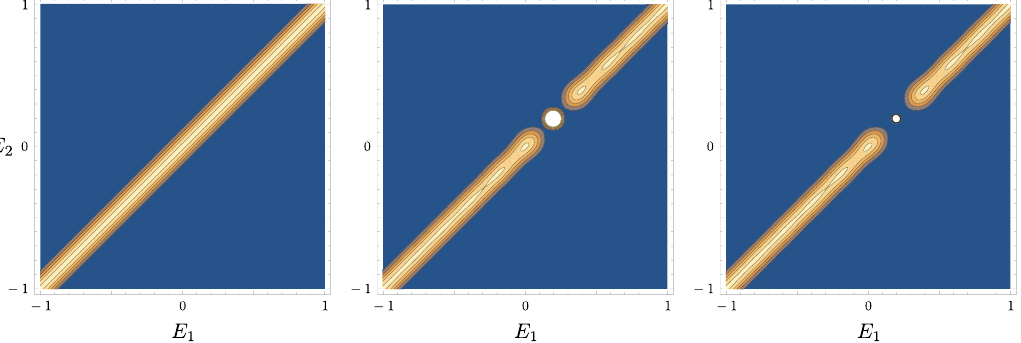
q for the theory where we gradually fix Figure 11: The spectral correlation T p E , E 1 2 one eigenvalue (127). For σ “ 8 (left) this is the characteristic sine-kernel of ran- dom matrix theory (131). For σ “ 0 (right) the spectral correlation is completely destroyed close to the fixed eigenvalue, modulo a delta spike (132). For finite but small σ (middle) the leading effect is a Gaussian smearing of this delta spike (143). Here κ “